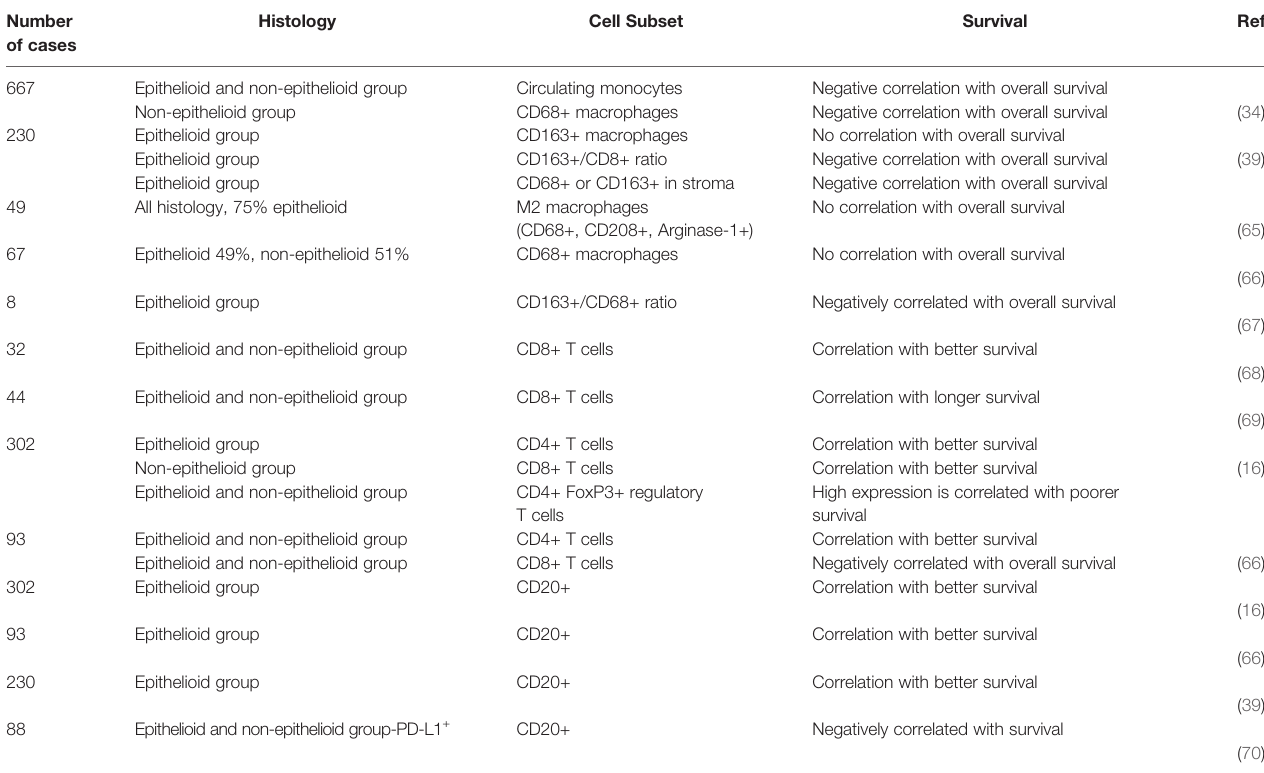
TABLE 1 | Summary of publications of overall survival correlated with immune in fi